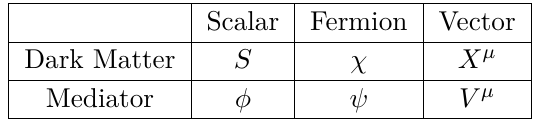
systematic uncertainties from propagation and source models to our particle model parameter